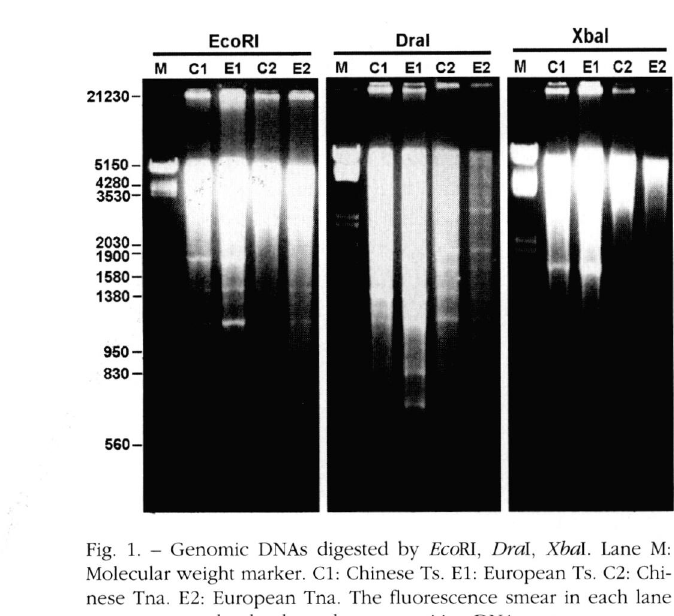
Fig. 1. - Genomic DNAs digested by EcoR I , Dral, Xbal. Lane M: Molecular weight marker. C1: Chinese Ts. E1: European Ts. C2: Chi nese Tna. E2: European Tna. The fluorescence smear in each lane represents randomly cleaved non-repetitive DNA sequence: super imposed bands are visualized in each lane and represent repetitive sequences. Fluorescence intensity in each band depends on the copy number of the multi sequence family as well as the length of the repeat unit.